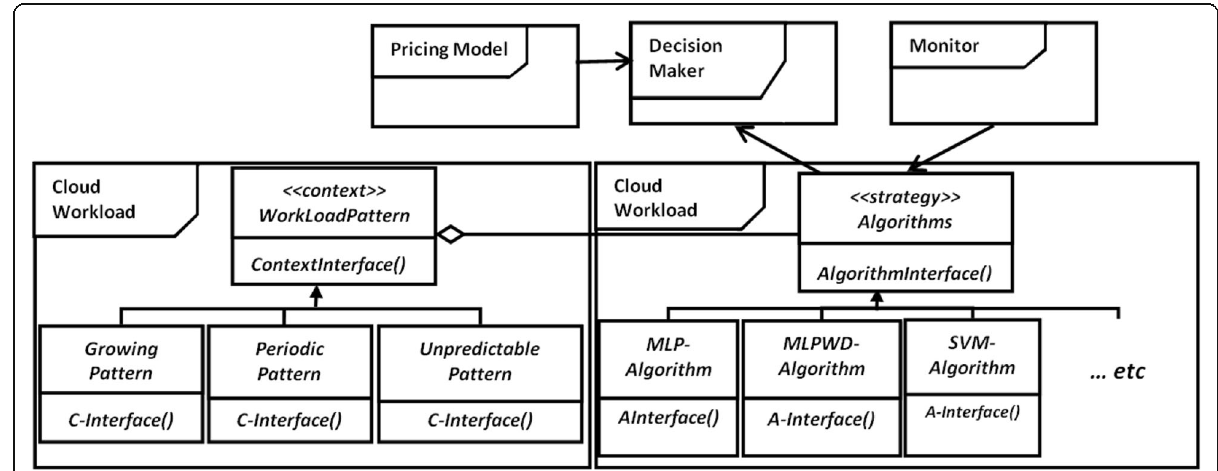
Fig. 4 The design of the autonomic elements using strategy design